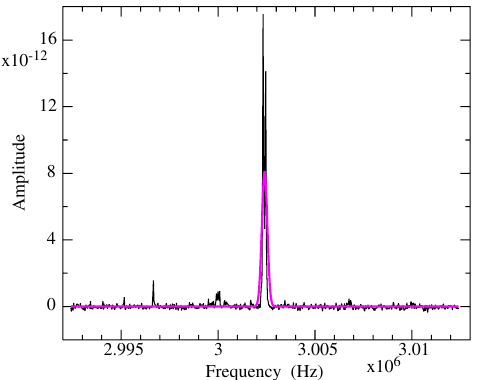
FIG. 5. Measurements of the vertical (top) and horizontal (bottom) beam profiles for a cooled beam. The purple curves represent Gaussian fits to the profile